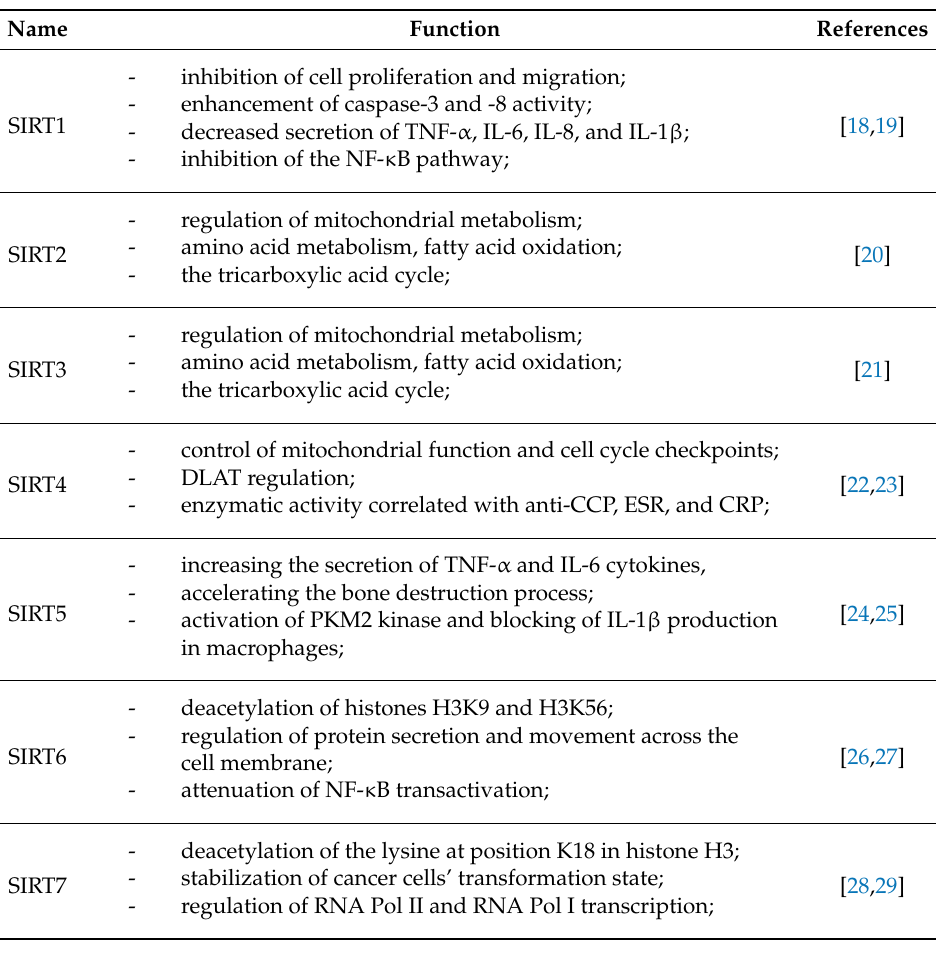
Table 1. The role of sirtuins in rheumatoid